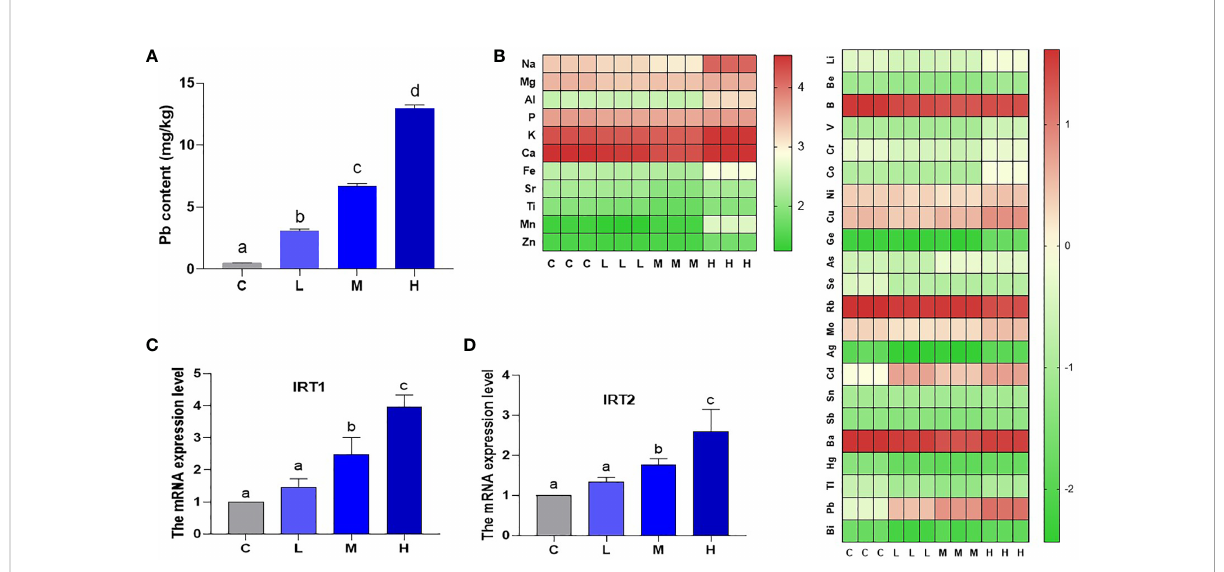
FIGURE 1 Pb content and total element content of leaves of pakchoi. (A) Pb content (mg/kg) in the leaves of pakchoi (45 d). (B) After Pb exposure in pakchoi, the heat map of total element content. High expression (red), Low expression (green). (C) qRT-PCR analysis of IRT1 mRNA level in